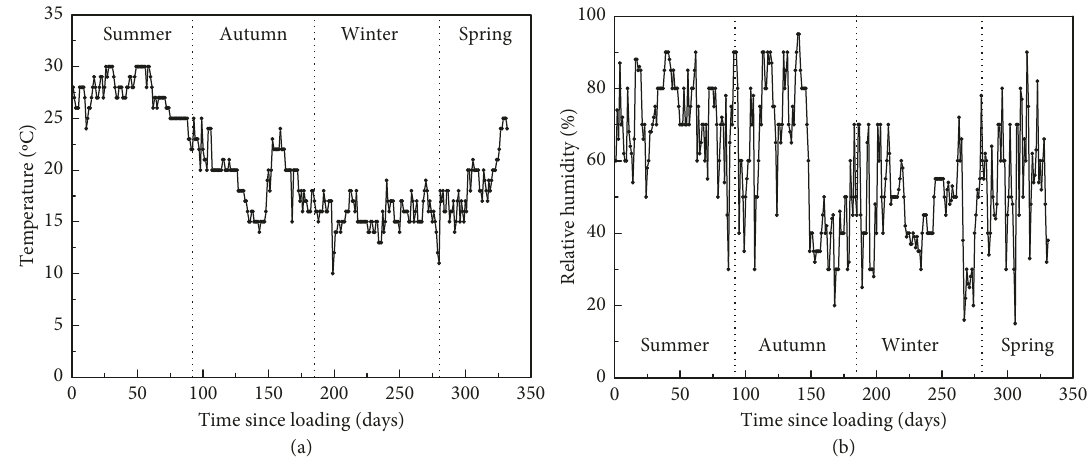
Figure 6: Temperature and humidity variations: (a) temperature; (b) relative